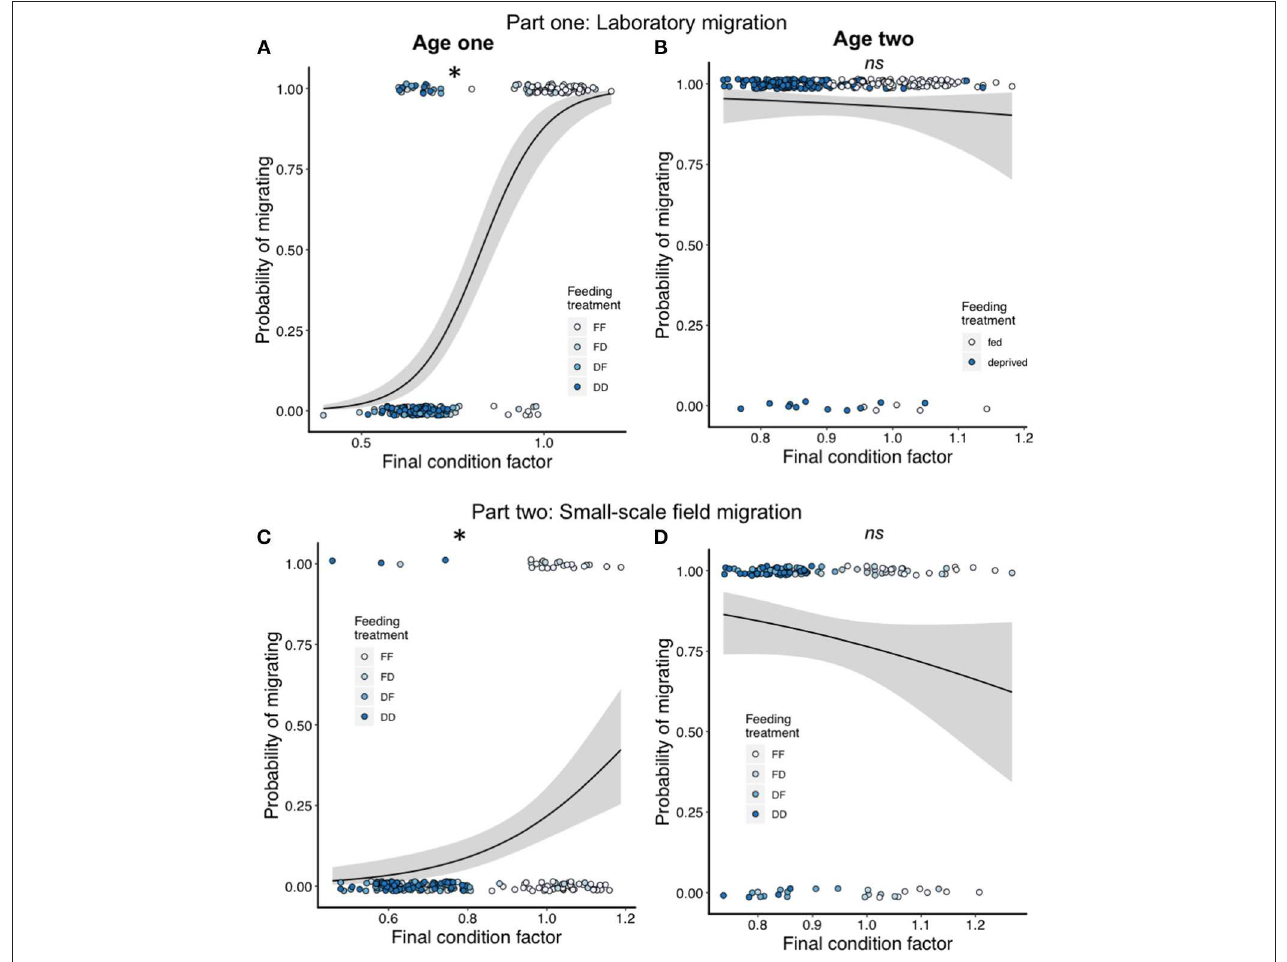
FIGURE 4 | Effect of final condition factor on the probability of migration for age one (A) and age two (B) fish in the laboratory migration study (part one); for age one (C) and age two (D) fish in the small-scale field migration study (part two). In all panels the solid line shows the mean with the shaded ribbon showing the 95% confidence interval of the mean. Feeding treatment groups are shown in different colors for reference, but were not included in the statistical models for these analyses. * indicates p < 0.05; ns indicates non-significant.